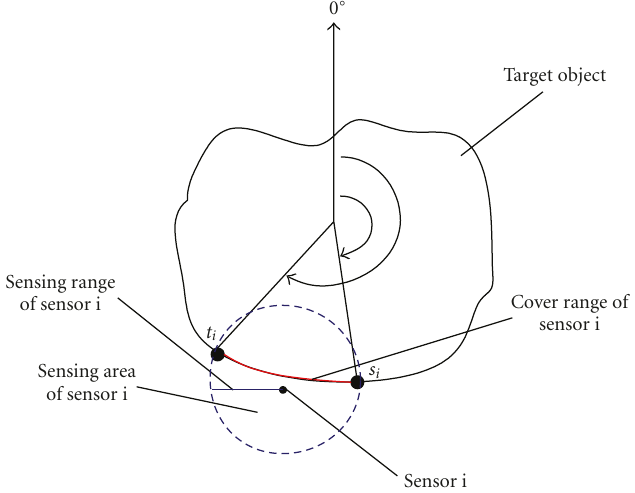
Figure 1: The cover range of sensor i.